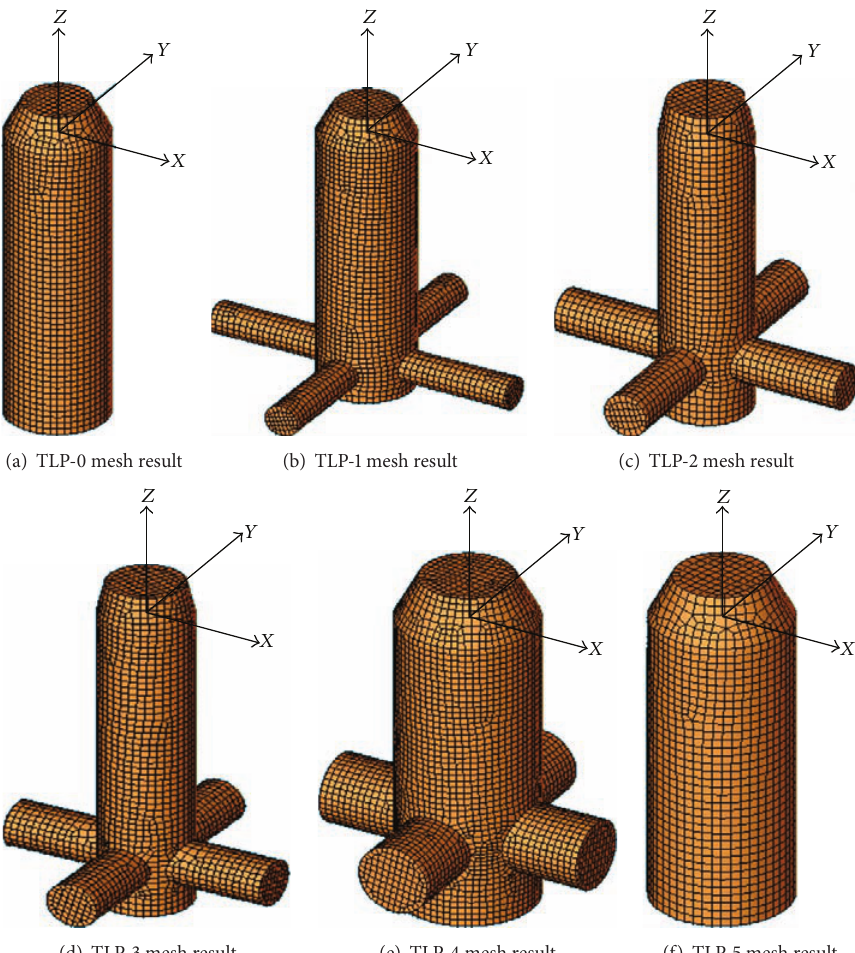
Figure 2: Mesh result for different models.